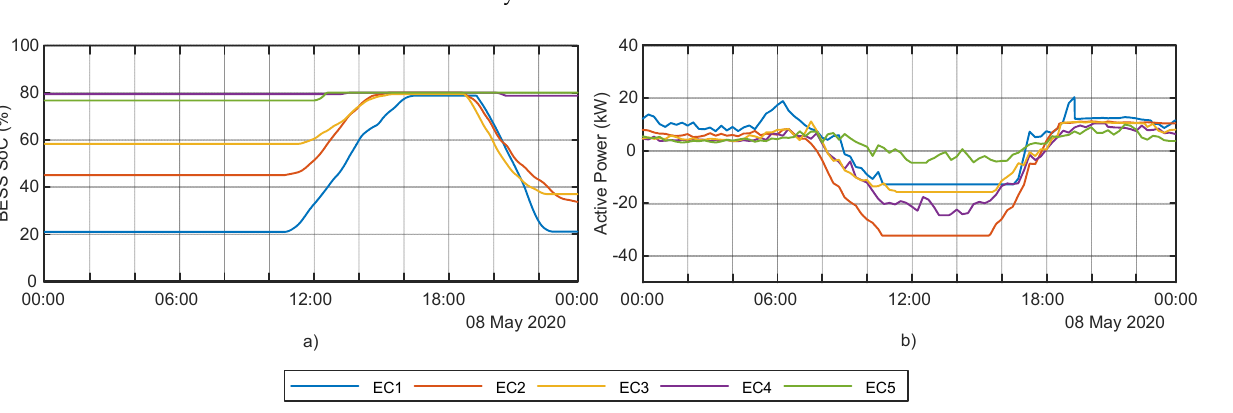
Figure 13. Net demand of the ECs with community storage for the selected case scenario. ( a ) The SoC variations of the BESS at the respective ECs. ( b ) The resulting net-demand at each EC.